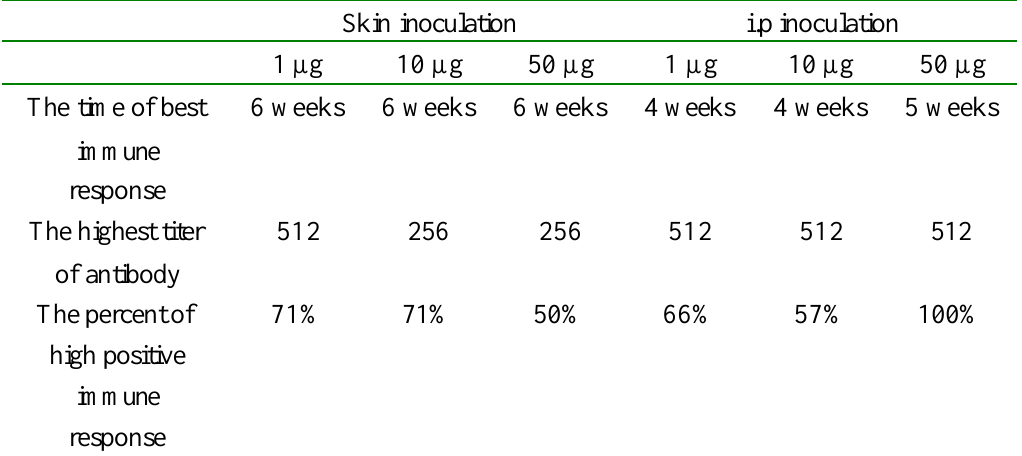
Table 2. The comparison of immune effect of DNA-liposome complexes by skin and i.p inoculation. Skin